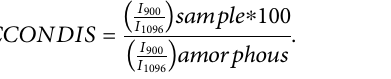
Frontiers in Energy Research |